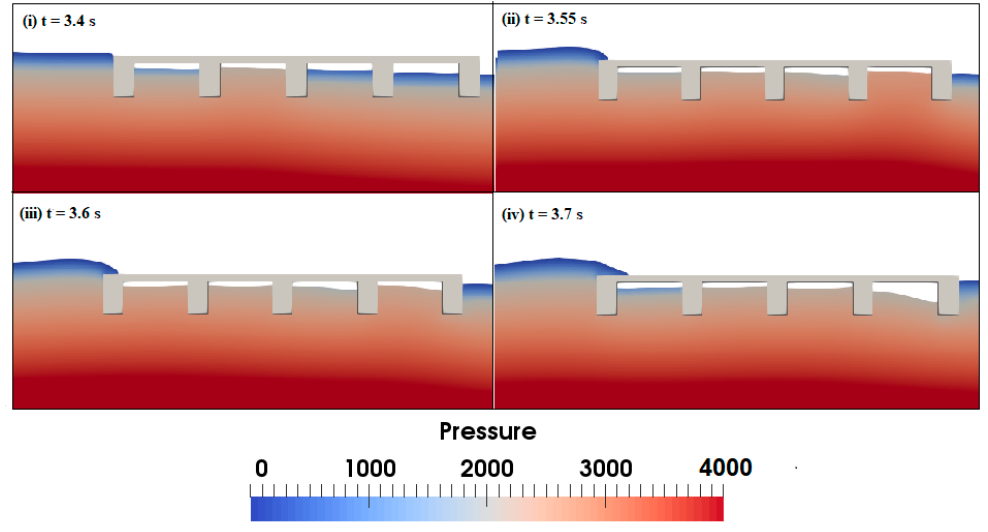
Figure 8. Color contour maps showing the variation of pressure (N/m 2 ) at different time steps during the solitary wave impact on the deck.